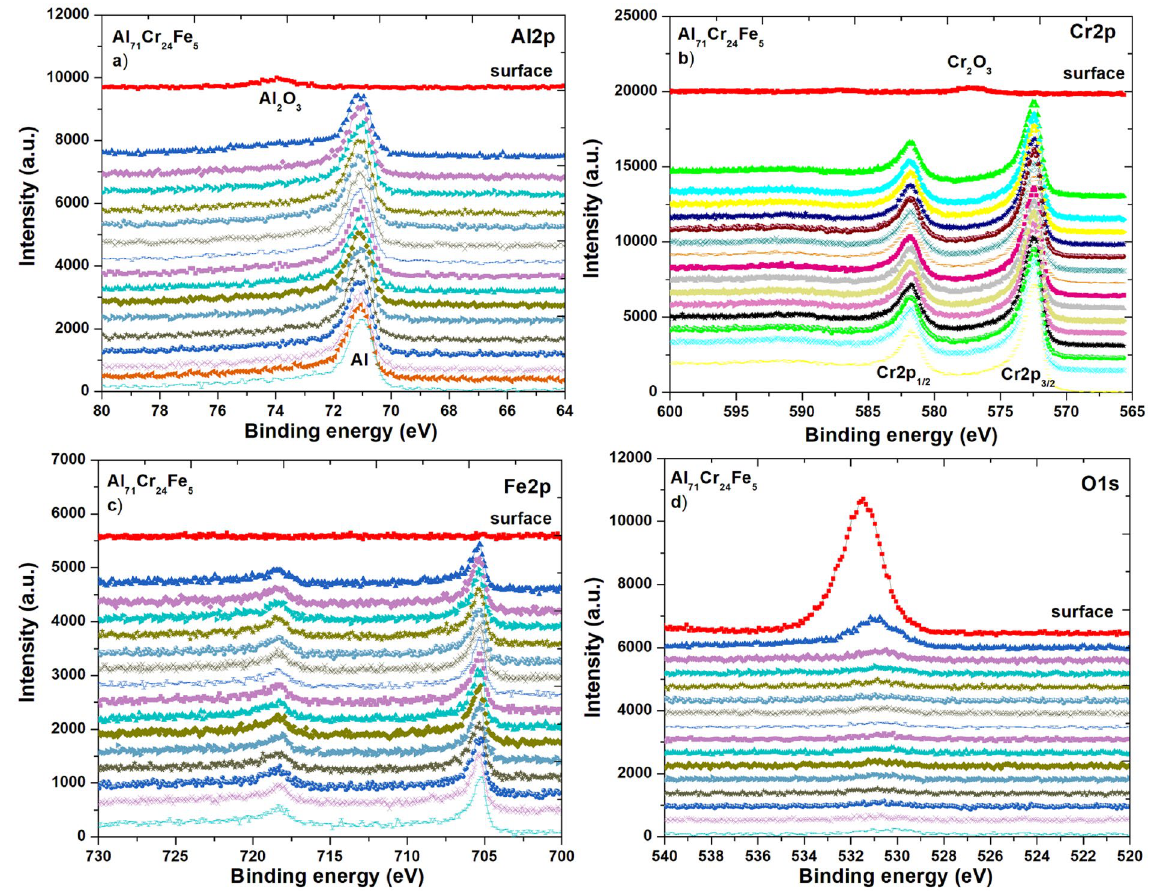
Figure 12. XPS core level lines of Al2 p ( a ), Cr2 p ( b ), Fe2 p ( c ), O1 s ( d ) of Al 71 Cr 24 Fe 5 plate after corrosion tests in 3.5% NaCl solution at 25 °C.